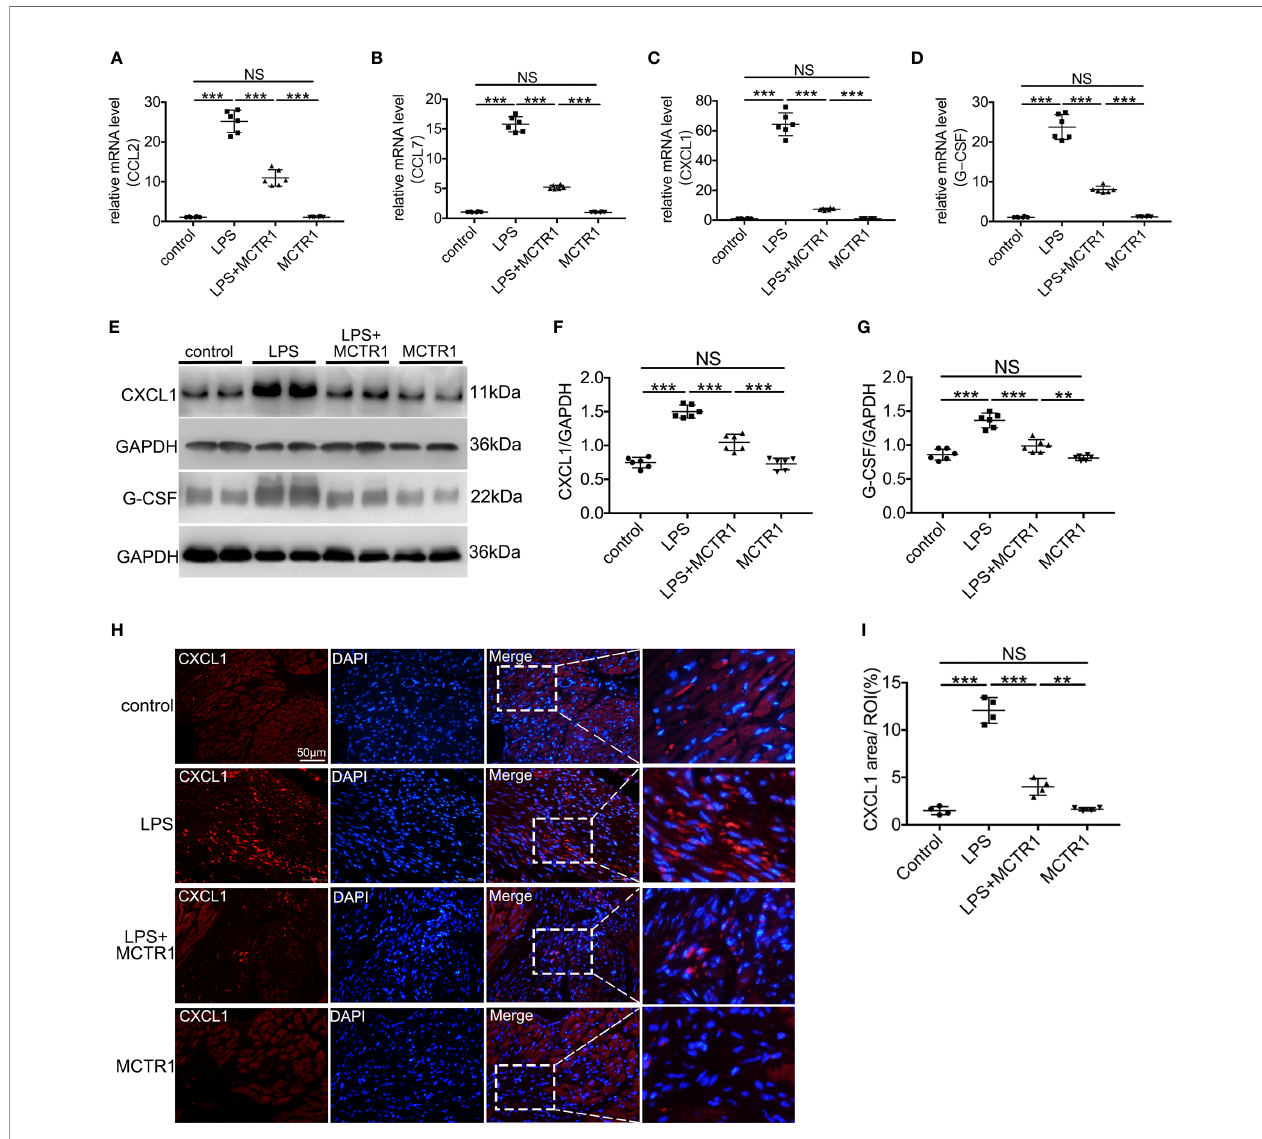
FIGURE 3 | The effect of MCTR1 on chemokines expression in cardiac injury after LPS administration. (A – D) mRNA expression levels of CCL2, CCL7, CXCL1 and G-CSF were examined using quantitative PCR in the hearts (n = 6). (E – G) Protein expression levels of CXCL1 and G-CSF were detected by western blotting. Densitometry ratios of target proteins to loading control GAPDH were obtained (n = 6). (H) The Representative immuno fl uorescence staining of CXCL1 in the hearts. (I) Fluorescence intensity of CXCL1 was determined by using Image J software (n = 4). Data are shown as means ± SD. ** P < 0.01; *** P < 0.001; NS, not signi fi